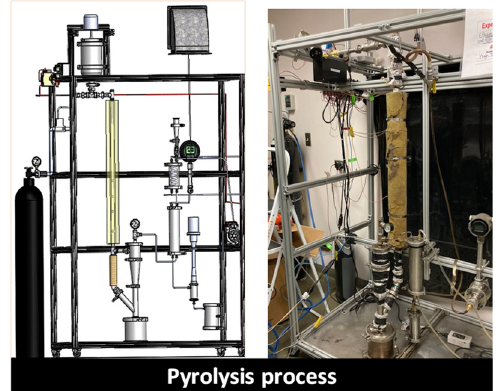
Figure 2. Mixed fast and slow pyrolysis process.